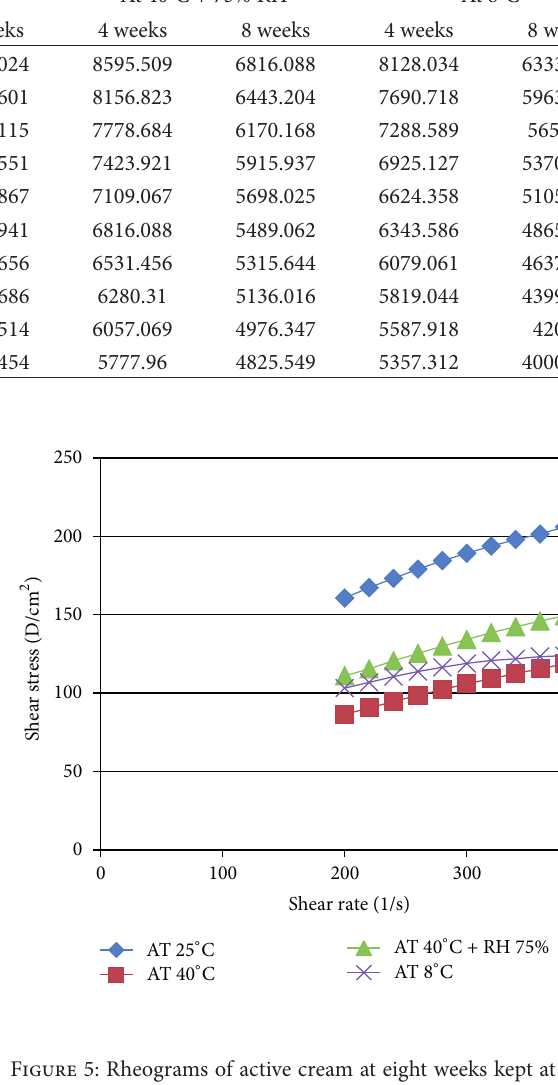
F 5: Rheograms of active cream at eight weeks kept at